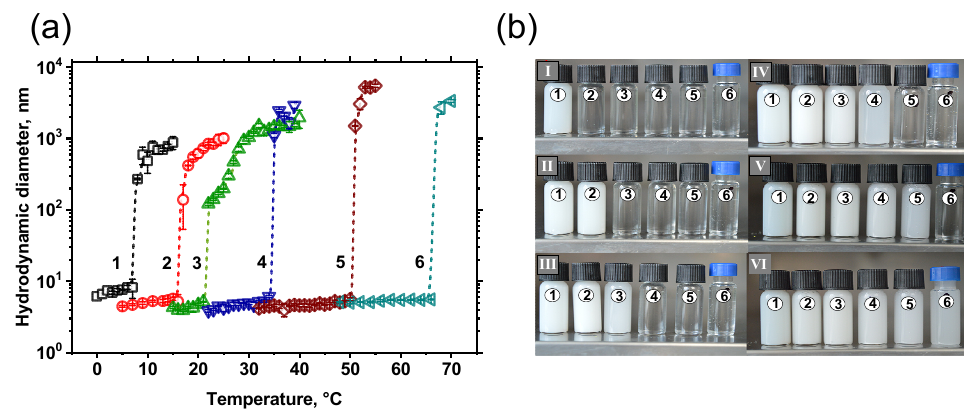
Figure 6. Changes in the hydrodynamic parameters under applied temperature of p (St- co - PEO 5 MEMA) copolymer with different styrene content (mol.%) in composition ( a ): 55.4 (1), 45.3 (2), 37.4 (3), 26.9 (4), 12.1 (5) 0 (6). The visual turbidity of the samples at different temperatures ( b ): 7 ◦ C (I), 17 ◦ C (II), 26 ◦ C (III), 32 ◦ C (IV), 49 ◦ C (V), 69 ◦ C